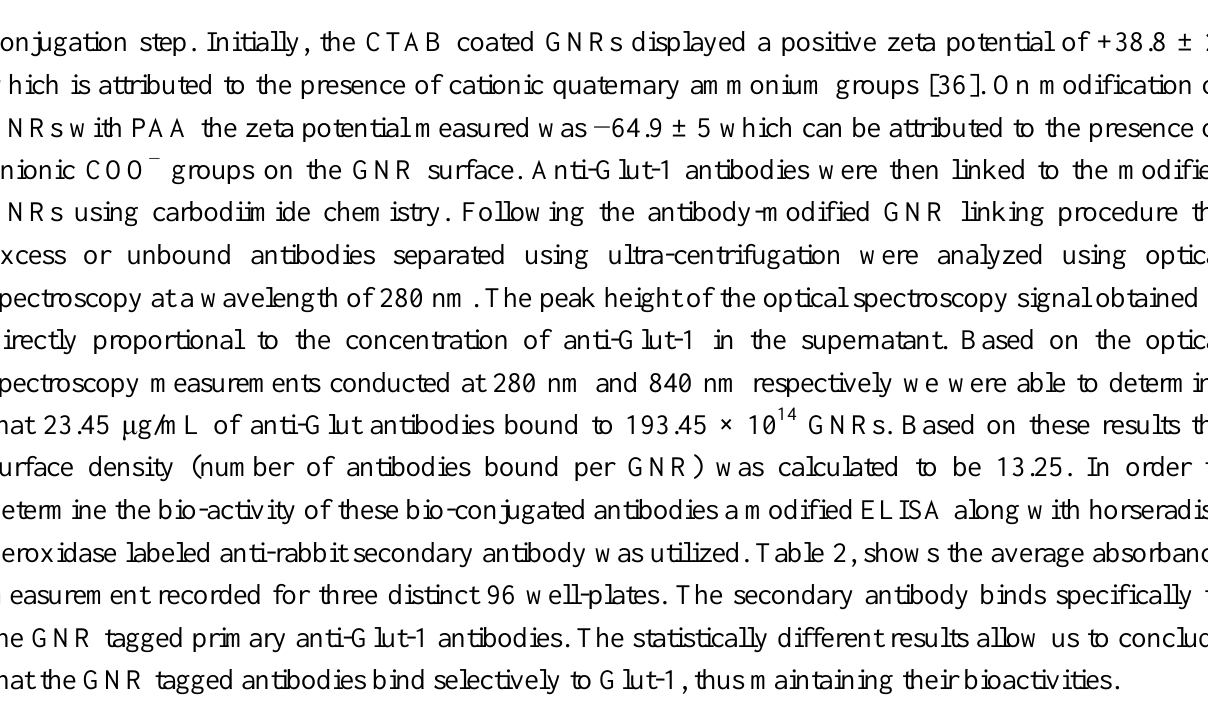
Table 1. Zeta potential measurements of gold nanorods recorded before and after surface modifications.